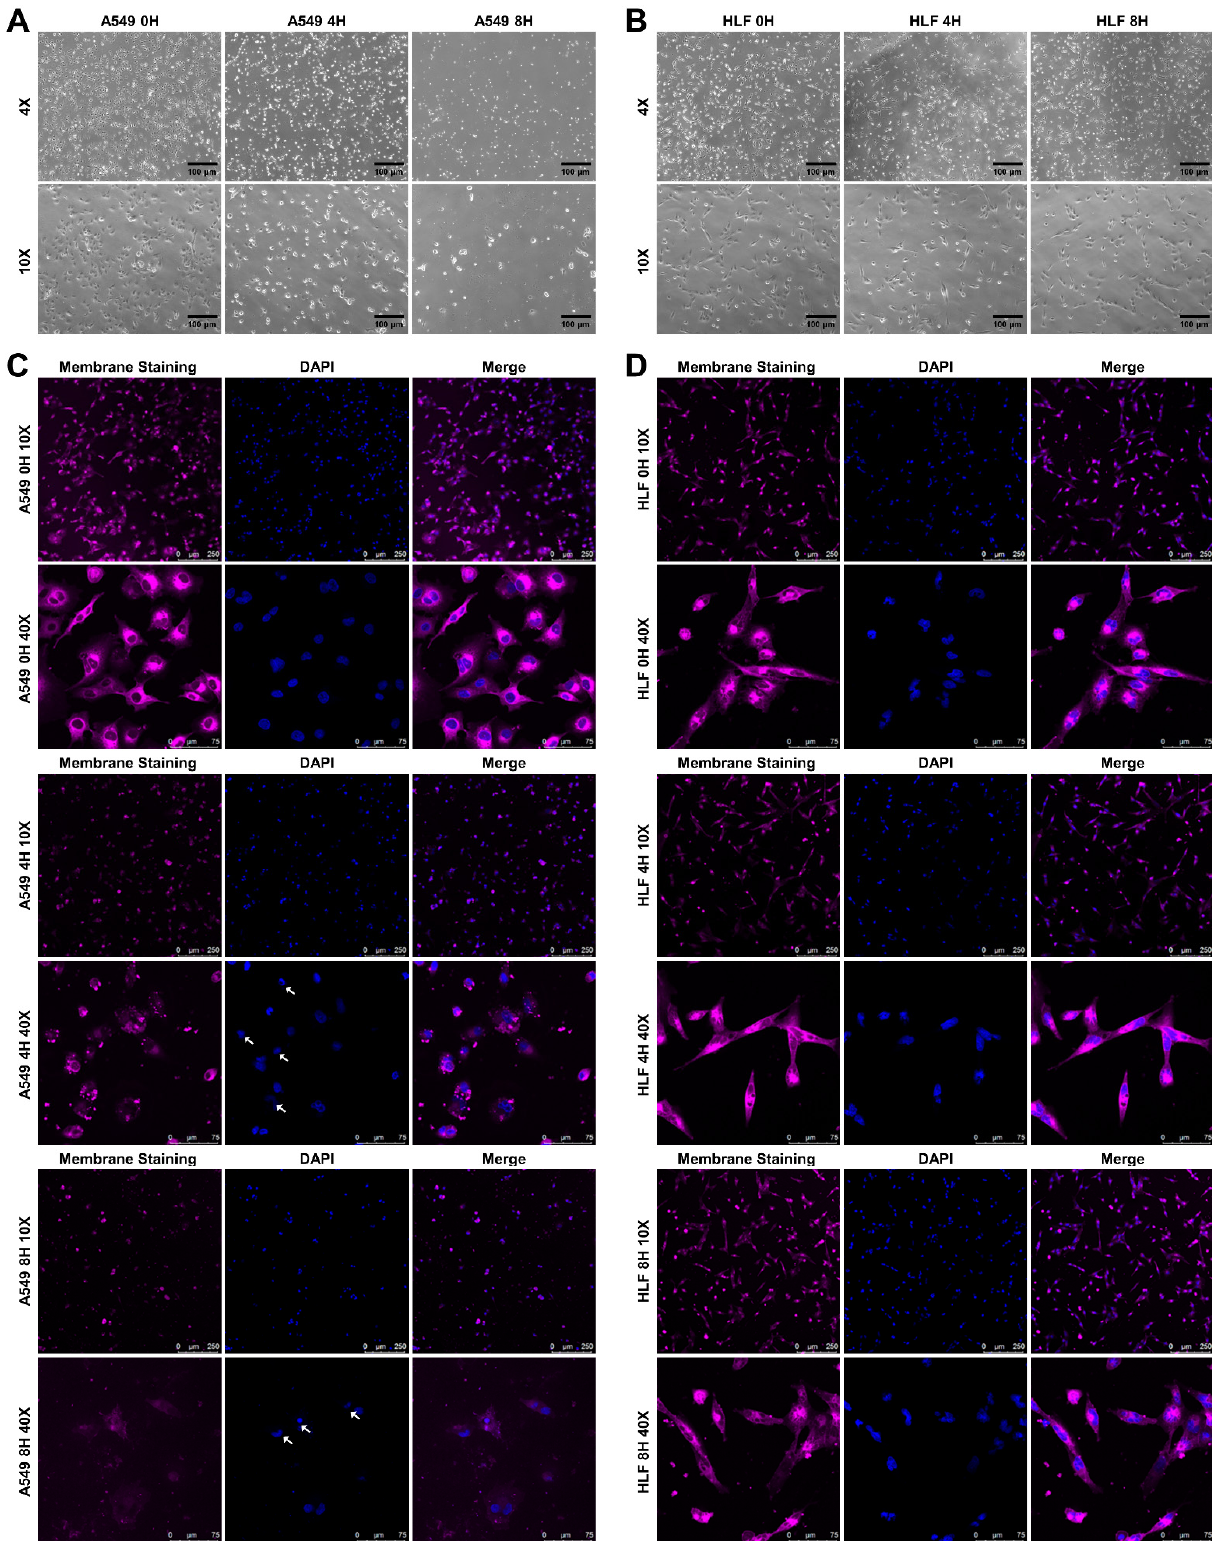
Figure 5. Morphological changes of ( A ) A549 and ( B ) HLF cells treated with K 4 F 6 K 4 for 0, 4, and 8 h were observed by optical microscopy. Additionally, the cell plasma membrane and nuclei of ( C ) A549 and ( D ) HLF cells treated with K 4 F 6 K 4 for 0, 4, and 8 h were stained with CellMask™ Deep Red plasma membrane dye and DAPI, respectively. The white arrows show the cells with typical apoptotic features after DAPI